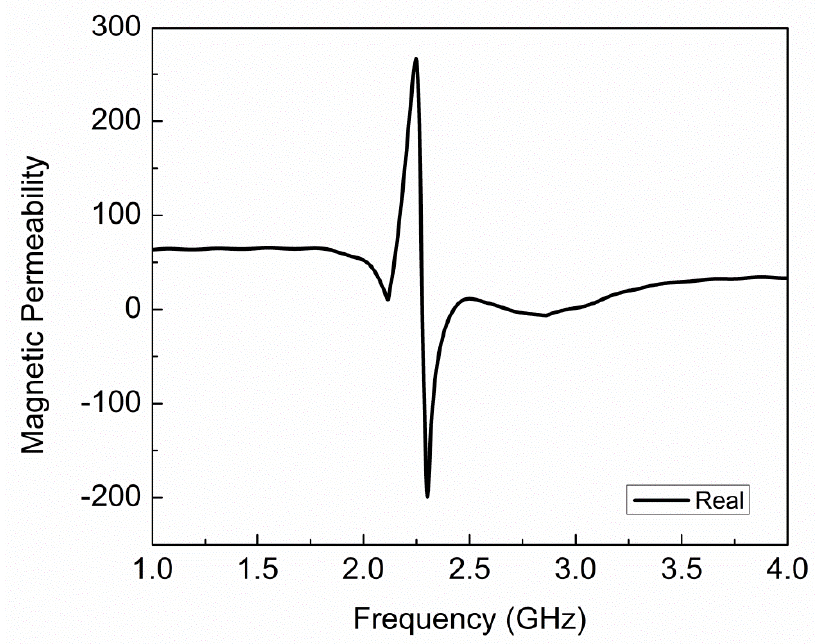
Figure 5. Extracted plot of magnetic permeability for proposed sensor, showing negative permeability from 2.27 GHz to 2.42 GHz, and maximum value of negative permeability is −199.2 at 2.30 GHz.